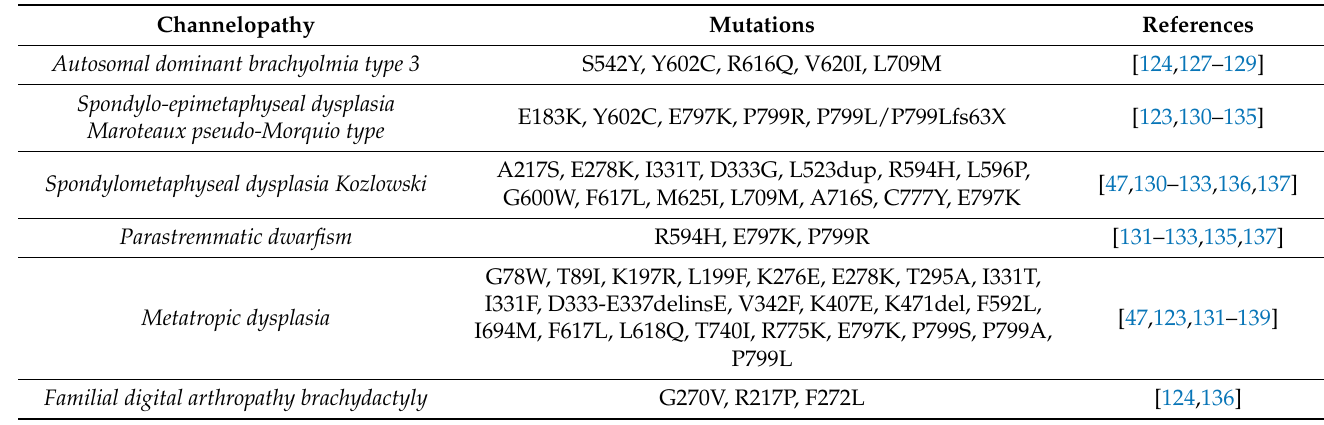
Table 1. Mutations causing different variants of skeletal